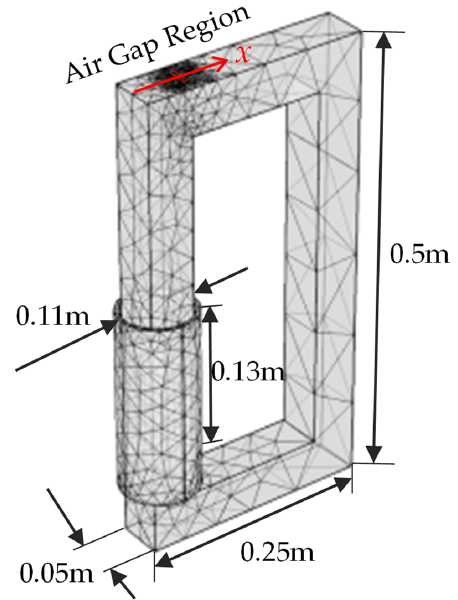
Figure 5. The configuration and FEM meshing of the transformer.